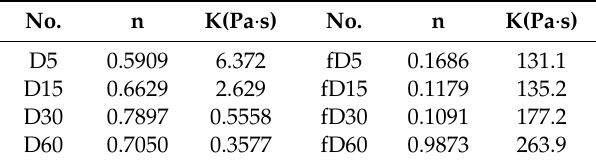
Table 3. Parameters of the Da-KGM system treated for di ff erent sonication time estimated by Power law equation. No. n K(Pa · s) No. n K(Pa · s) D5